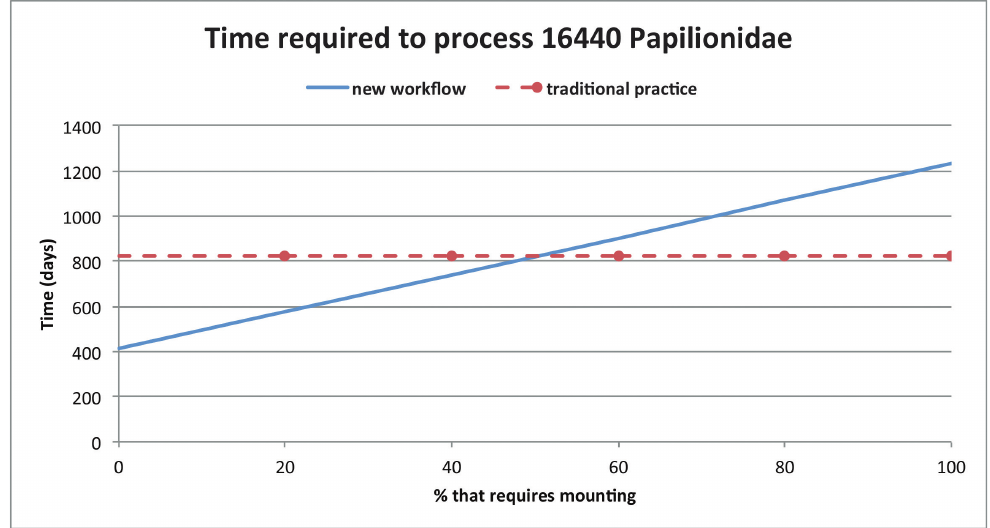
Figure 8. Time required to process 16,440 Papilionidae. When more than 50% of the digitized Lepidoptera specimens require mounting after digitization, the new workflow will become